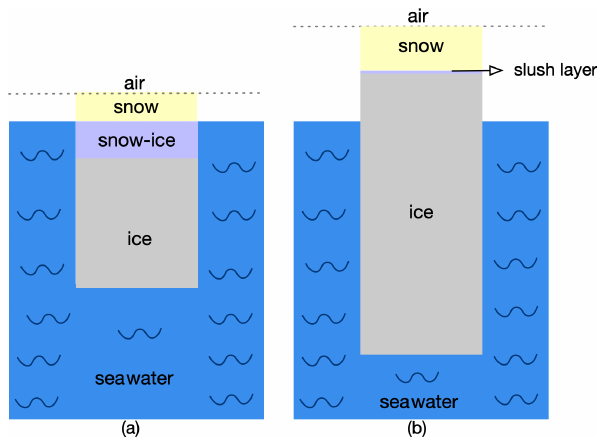
Figure 1. Schematic of (a) thinner ice floes flooded by seawater and (b) thicker ice floes without